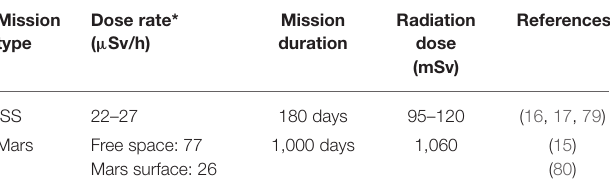
TABLE 2 | Estimated radiation exposure during space missions. Mission